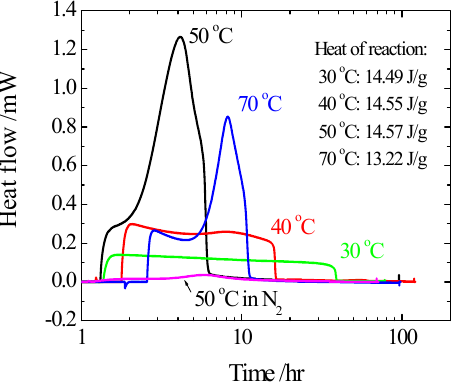
Figure 4. TAM isothermal test results of wood chips (sample: about 2